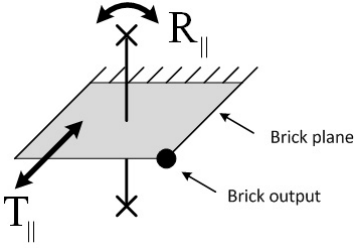
Figure 3. Mobility of the T k R ⊥ brick.